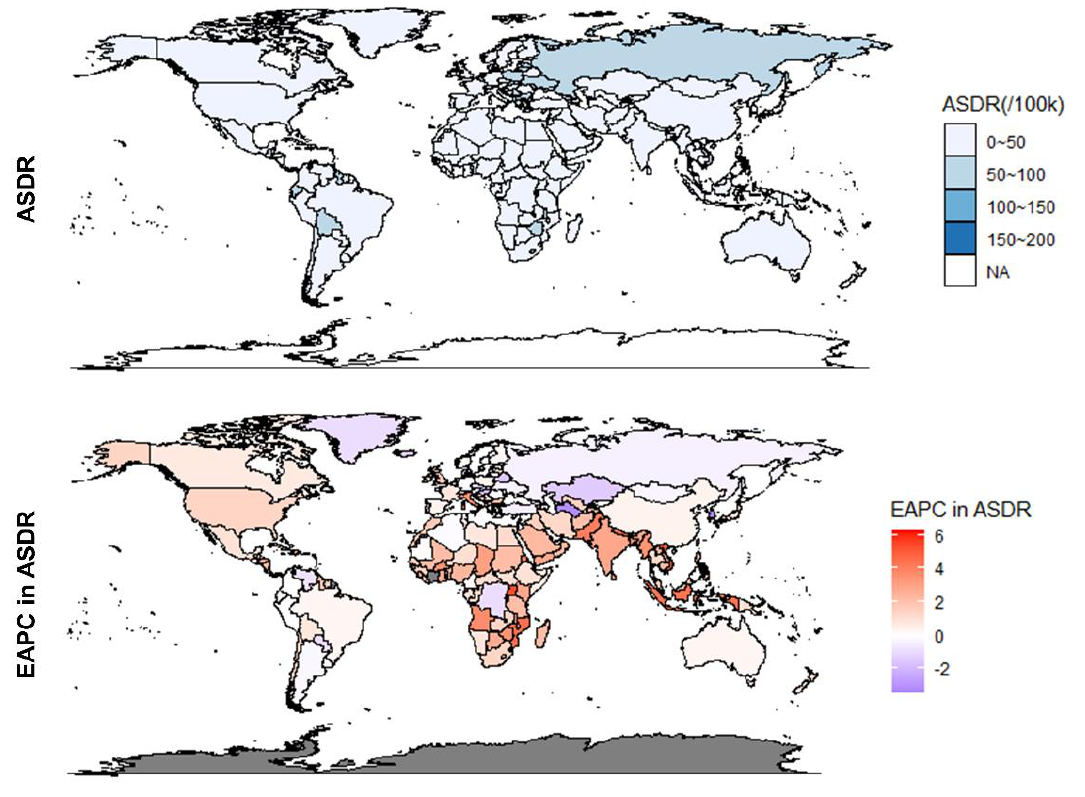
Figure 5. ASDR in 2019 for 204 countries and regions and their EAPC between 1990 and 2019. ASDR, Age-standardized DALY rate; EAPC, Estimated annual percentage change.